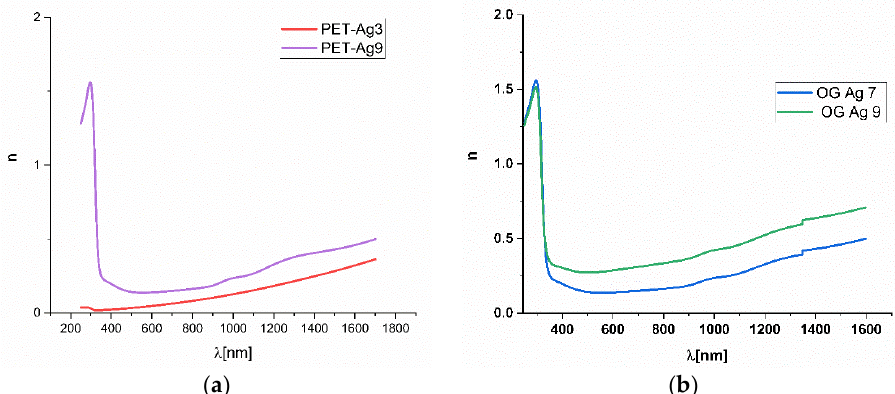
Figure 6. The variation of refractive index n with the wavelength for Ag deposited on thick PET ( a ) and optical glass SO ( b ).